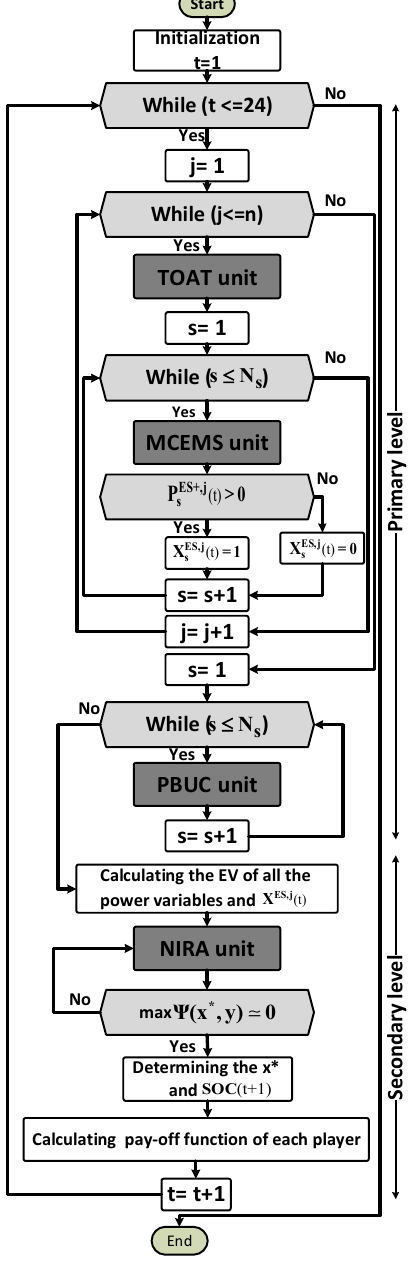
Figure 4. Flowchart of the proposed algorithm for implementing the retail energy market based on Nikaido-Isoda/relaxation algorithm (REM-NIRA). Taguchi’s orthogonal array testing (TOAT) unit, modified conventional energy management system (MCEMS) unit, and price-based unit commitment